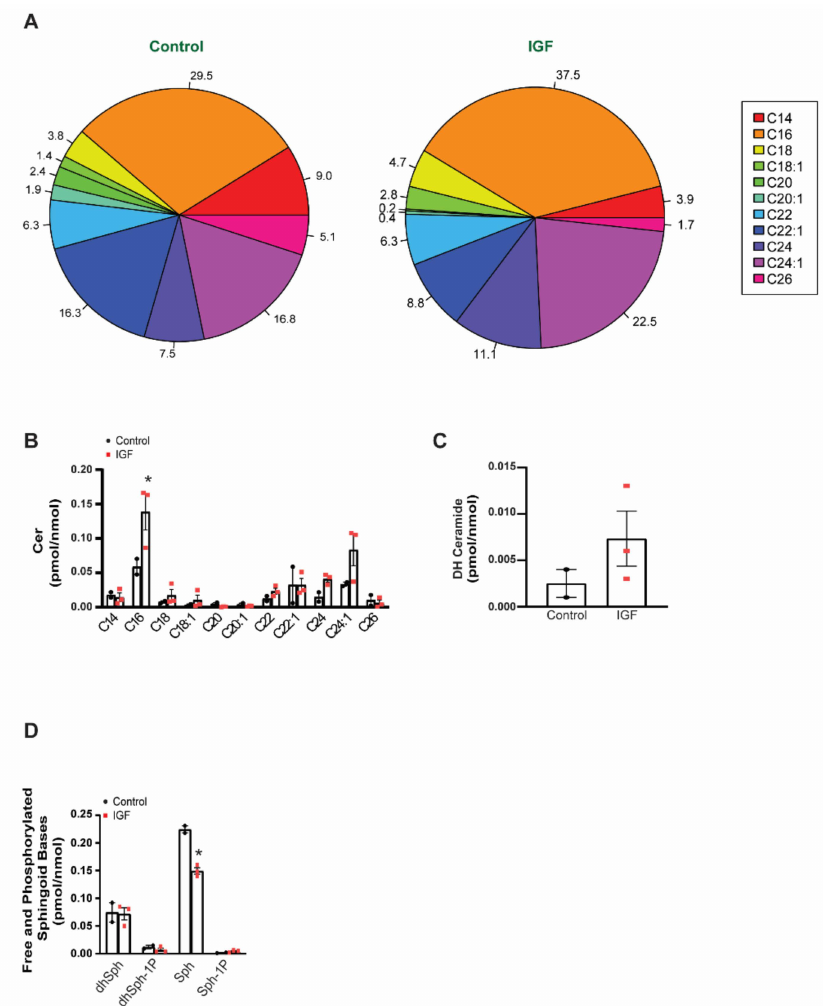
Figure 6. Effect of IGF-1 treatment on the ceramide (Cer) composition of myotube-derived EVs: ( A )—pie chart highlighting the Cer species in EVs derived from the control and IGF-treated my- otubes; ( B )—Cer species normalized for the amount of lipid-associated phosphate (a measure of total phospholipids in each preparation). Total amount of dihydro-ceramide (DH) ( C ) and sphingoid bases ( D ) between the control and IGF EVs. dhSph: dihydrosphingosine; dhSph-1P: dihydrosphingosine- phosphate; Sph: sphingosine; Sph-1P: sphingosine-phosphate. Data are presented in percentage ( A